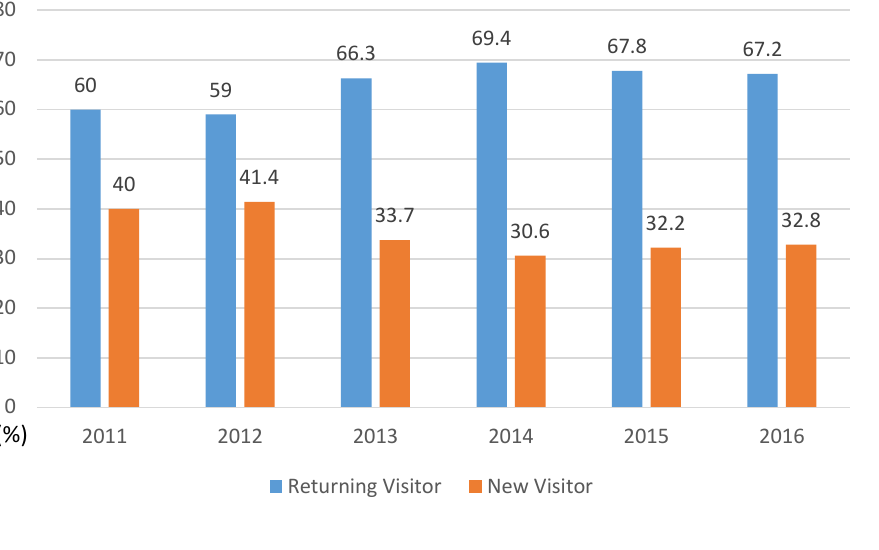
Figure 5. Type of NTU OCW